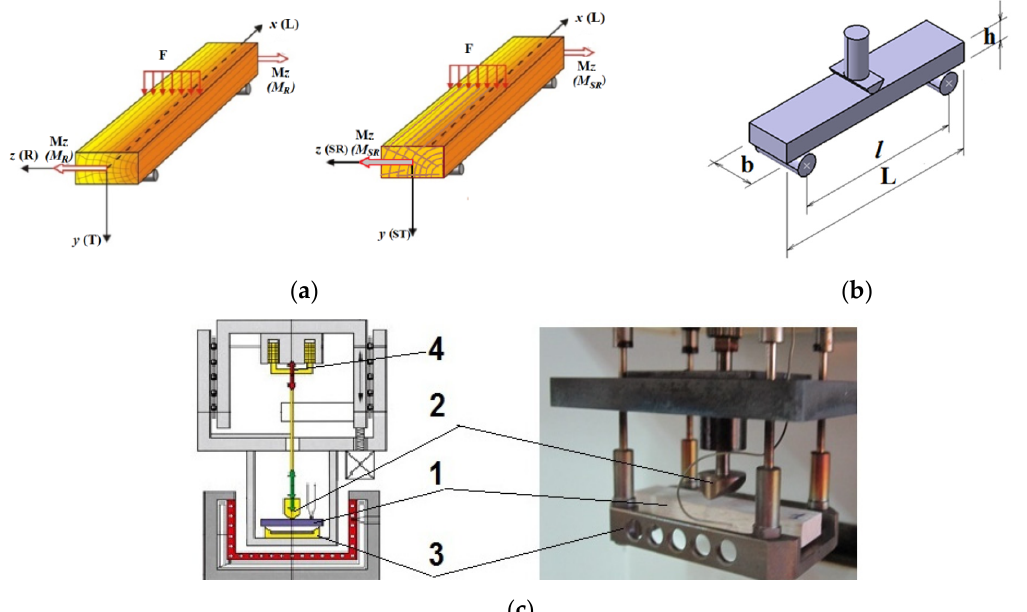
Figure 4. The DMA experimental set-up: ( a ) the types of wood samples (L –longitudinal direction, along wood grain; R–radial direction; T–tangential direction; SR – semi-radial direction; ST–semi- tangential direction); ( b ) the sample position on the equipment supports; ( c ) the main parts of DMA 242C Netzsch equipment: 1–specimen, 2–force application device, 3–specimen fixing/support devices, 4–electronic system for cyclic force application.